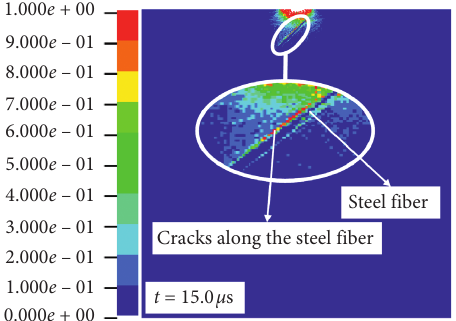
t = 18.0 μ Figure 5: Obstruction effect of steel